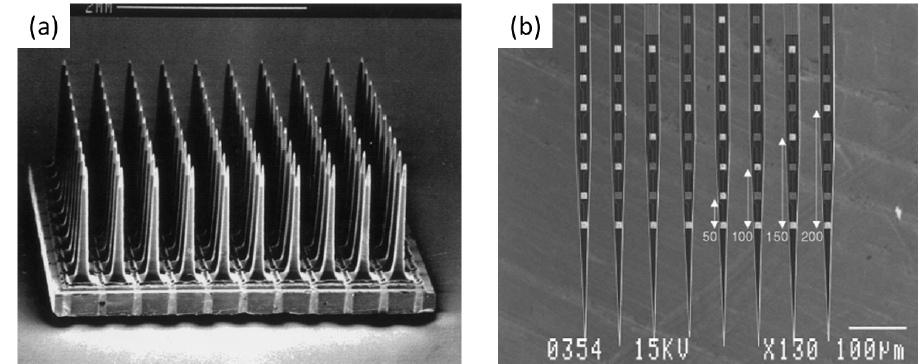
Figure 4. Representative microelectrode ( a ) Utah electrode [70], Copyright 1999, Elsevier; ( b )